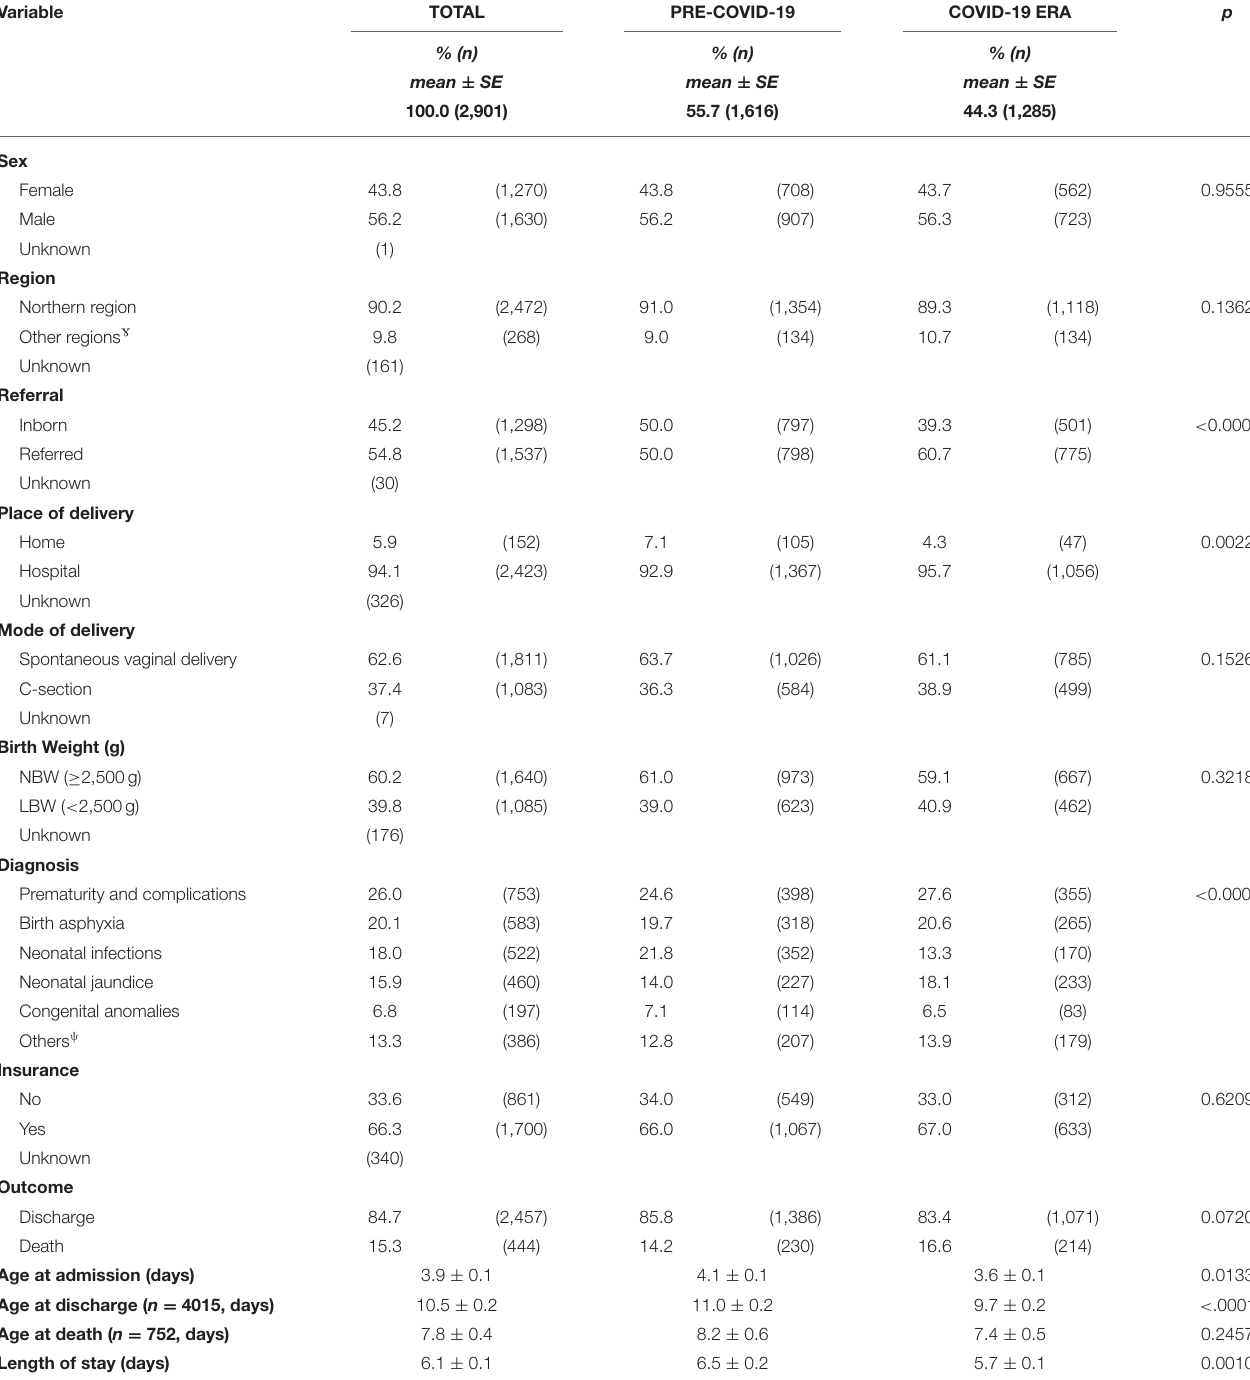
TABLE 1 | General characteristics of neonates admitted in TTH NICU during pre-COVID-19 and COVID-19